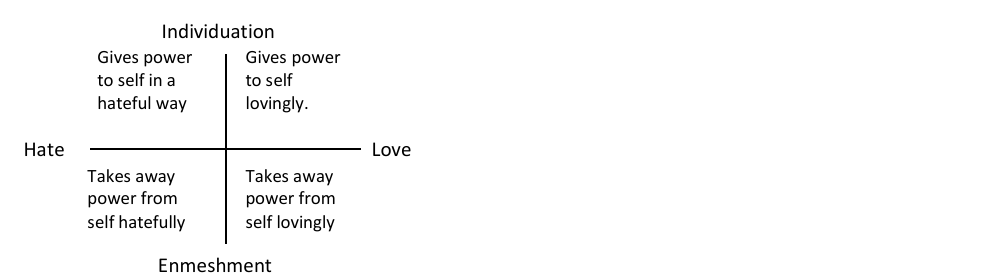
Figure 3: The Self Surface (Scilligo, 2006, pg. 180)